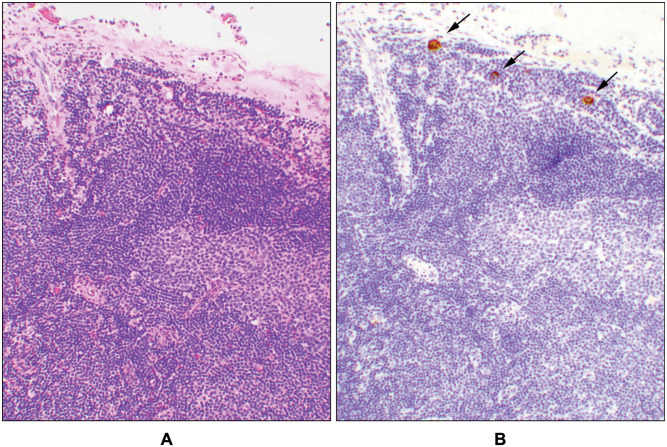
Isolated tumor cells.A sentinel lymph node with isolated tumor cells (case # 50, S1 and S5 Tables). (A) The photomicrograph shows a portion of a normal-appearing lymphoid structure with no obvious tumor cells by hematoxylin and eosin (H&E) stain. (B) Few isolated tumor cells were highlighted by cytokeratin immunohistochemical stain (arrows) within the same area of the lymph node as seen on the H&E slide (10x objective).